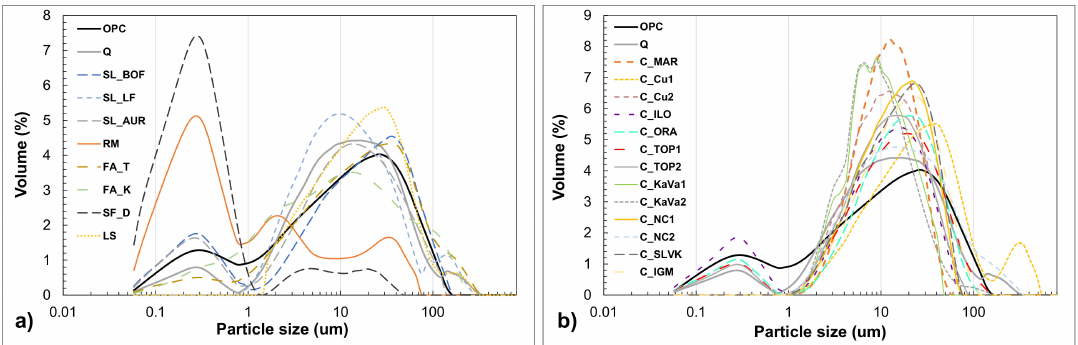
Figure 4. Particle size distribution of selected materials, OPC and quartz obtained by laser di ff raction after drying and grinding in a disc mill, ( a ) slags, iron silicate, red mud, fly ashes, silica fume and limestone ( b ) clay samples.